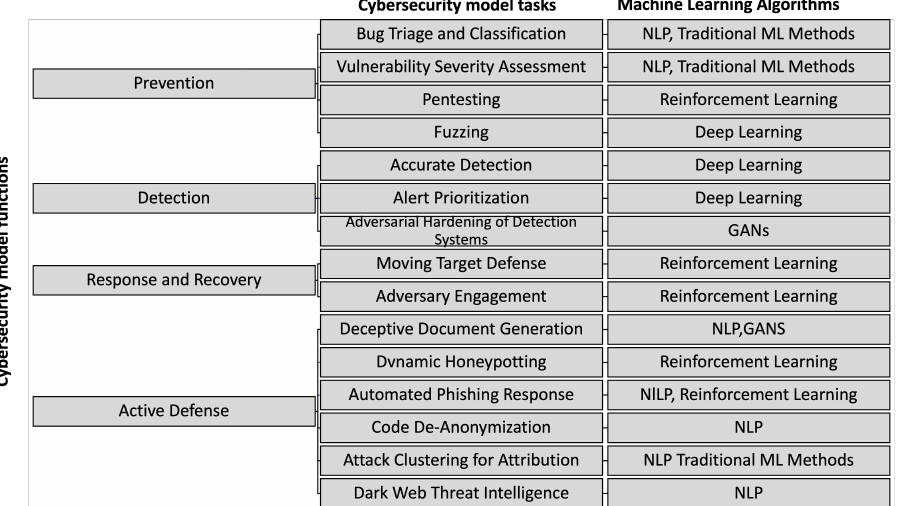
Figure 1. Taking into account the elements of the NIST layered security, CSET provides a model where different algorithms are applied and adapted to ML tasks, generating new opportunities for improvement in terms of prevention, detection, response & recovery and active defense. From where, GAN stands for Generative Adversarial Network - and NLP stands for Natural Language